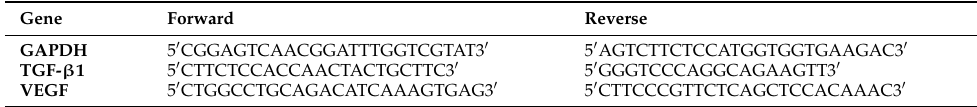
Table 3. Primer sequences of target